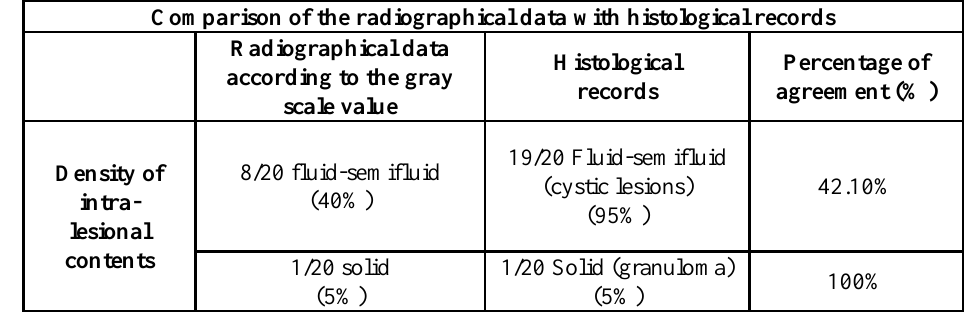
Table 3: Statistical analysis of radiographical data versus histological findings of the lesions Comparison of the radiographical data with histological